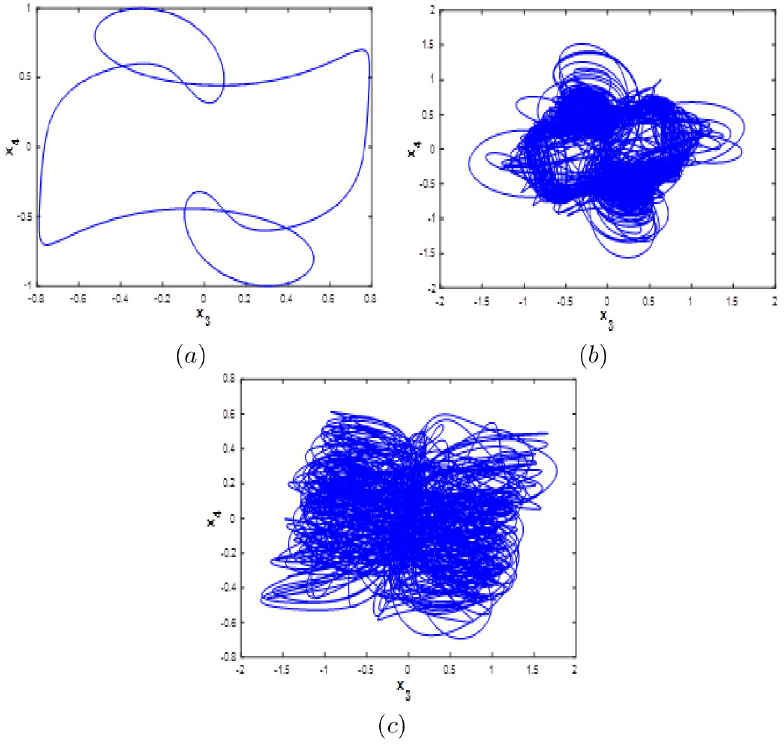
Fig 6. Phase portraits of the new 10-D system (1) for different values of b . (a) x 3 − x 4 Periodic attractor, (b) x 3 − x 4 chaotic attractor and (c) x 3 − x 4 hyperchaotic attractor.